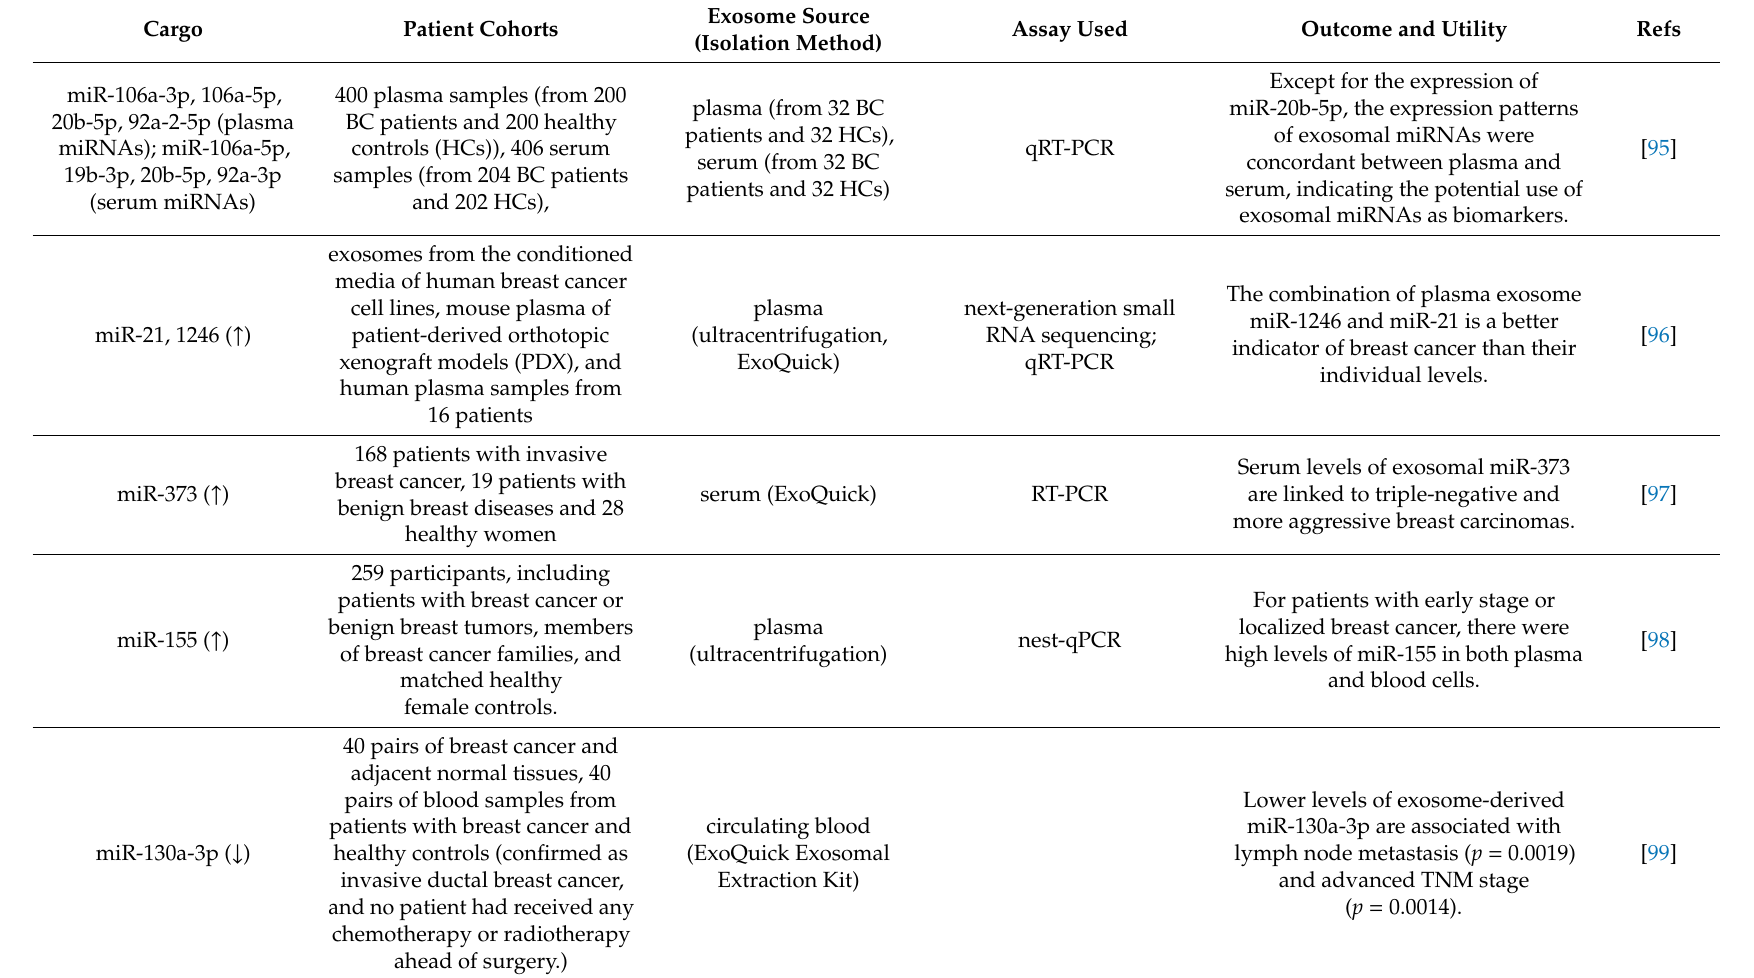
Table 4. Preclinical evaluation of exosomal cargo as cancer